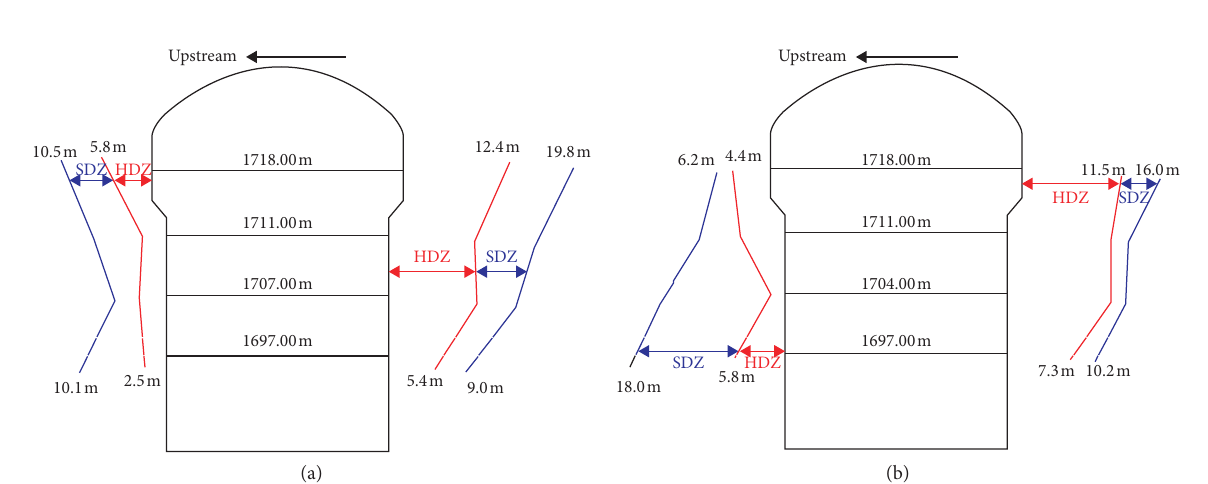
Figure 15: Depths of EDZs distributed in typical measured sections of Houziyan hydropower project: (a) section 0+008.8m and (b) section of 0+041.3m.